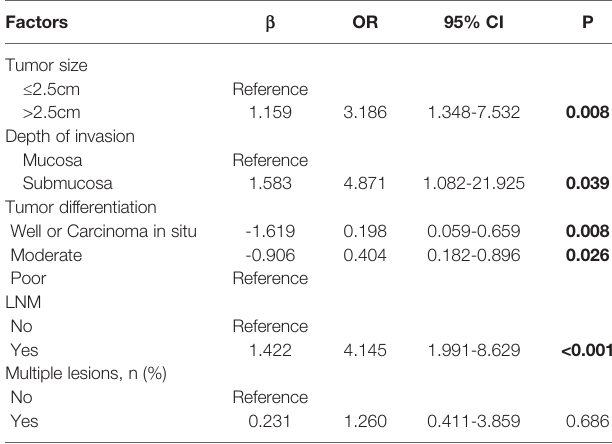
The bold values mean statistical signi fi